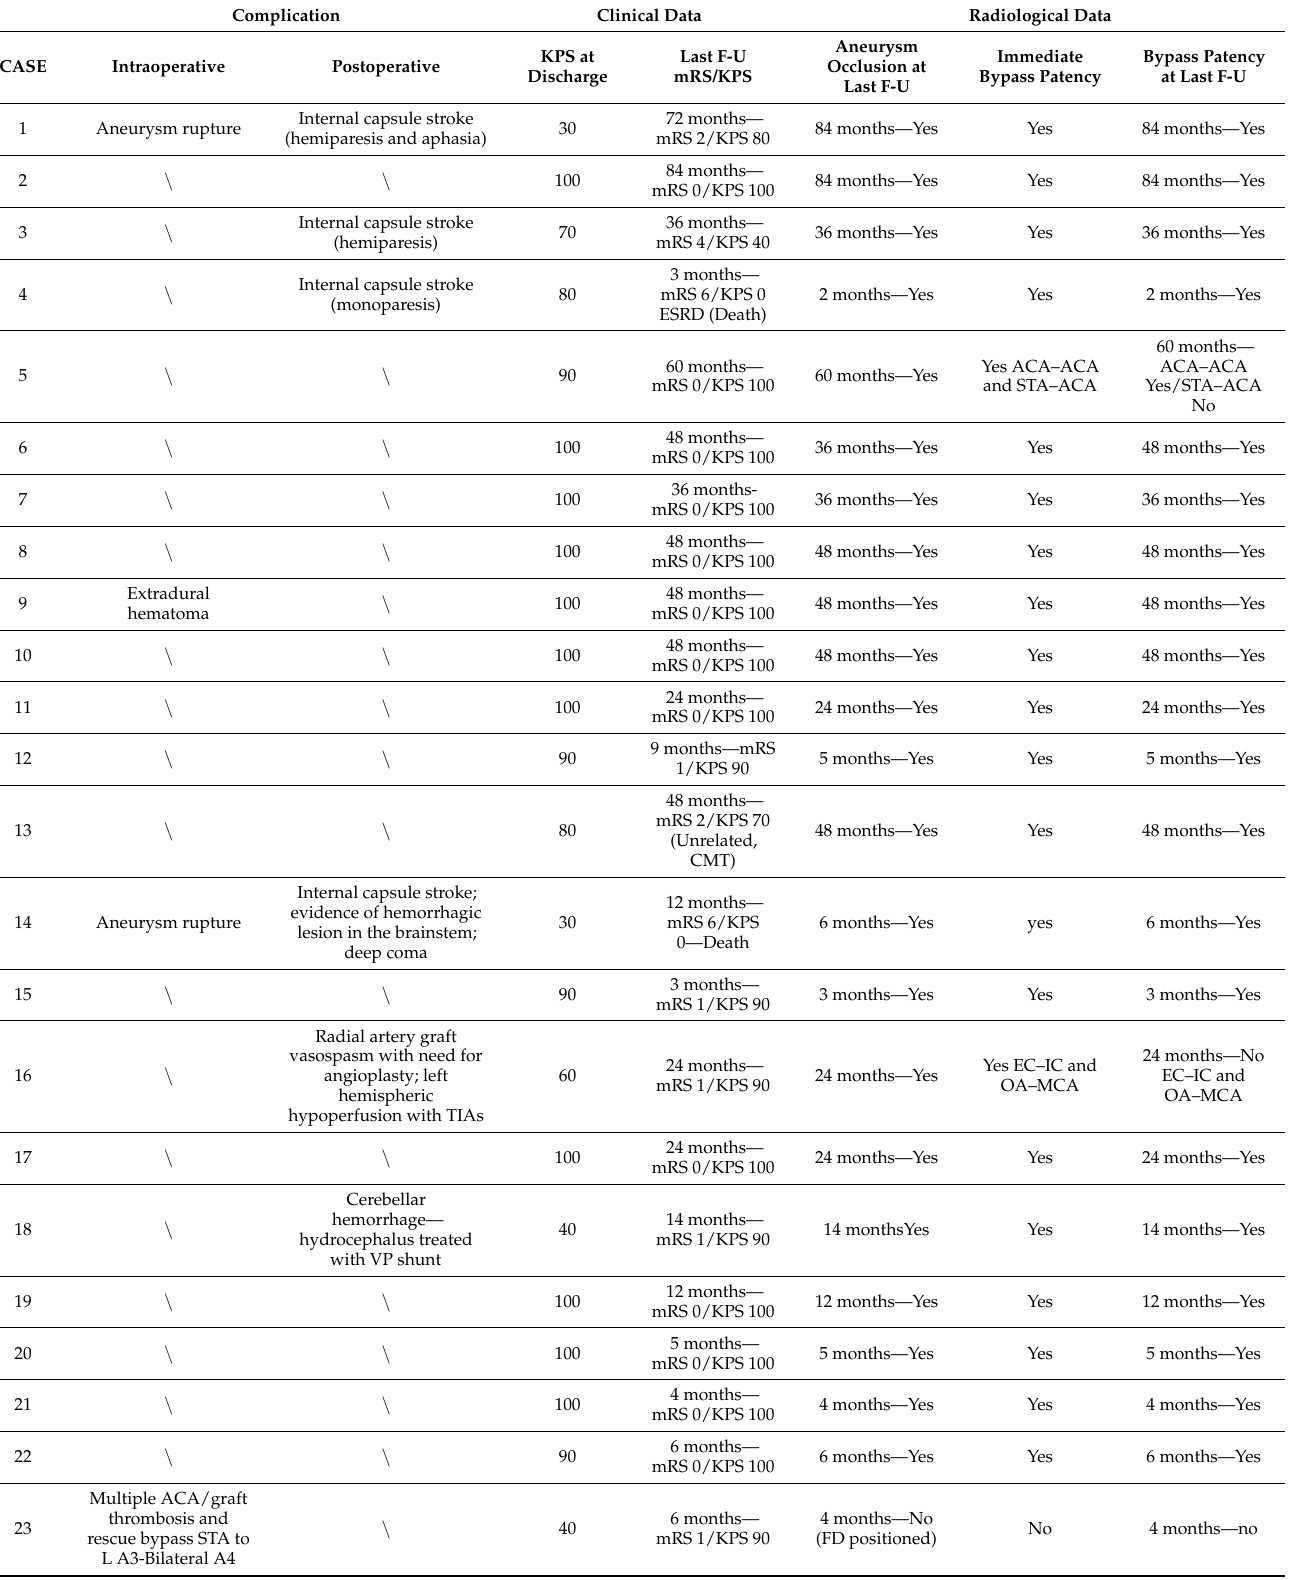
Table 3. Summary of clinical and radiological short- and long-term